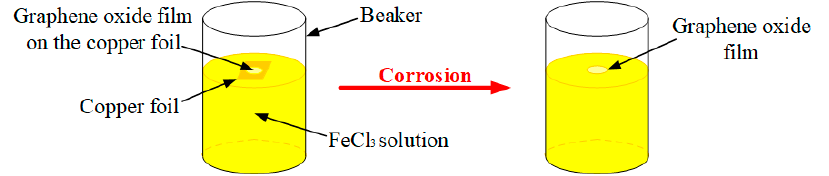
Figure 4. Corrosion of copper substrates.